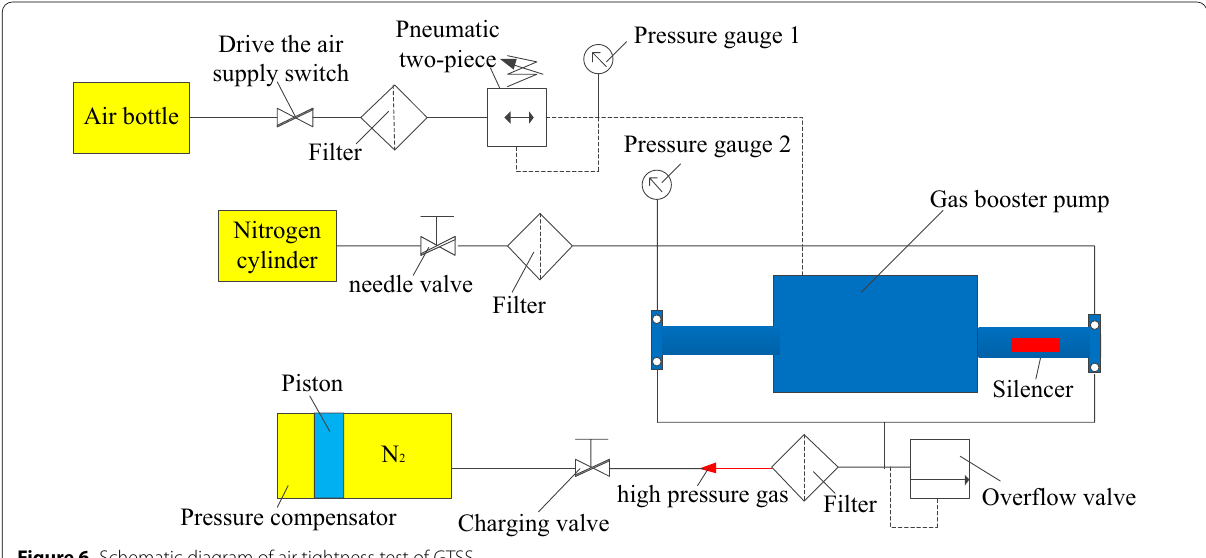
Figure 6 Schematic diagram of air tightness test of